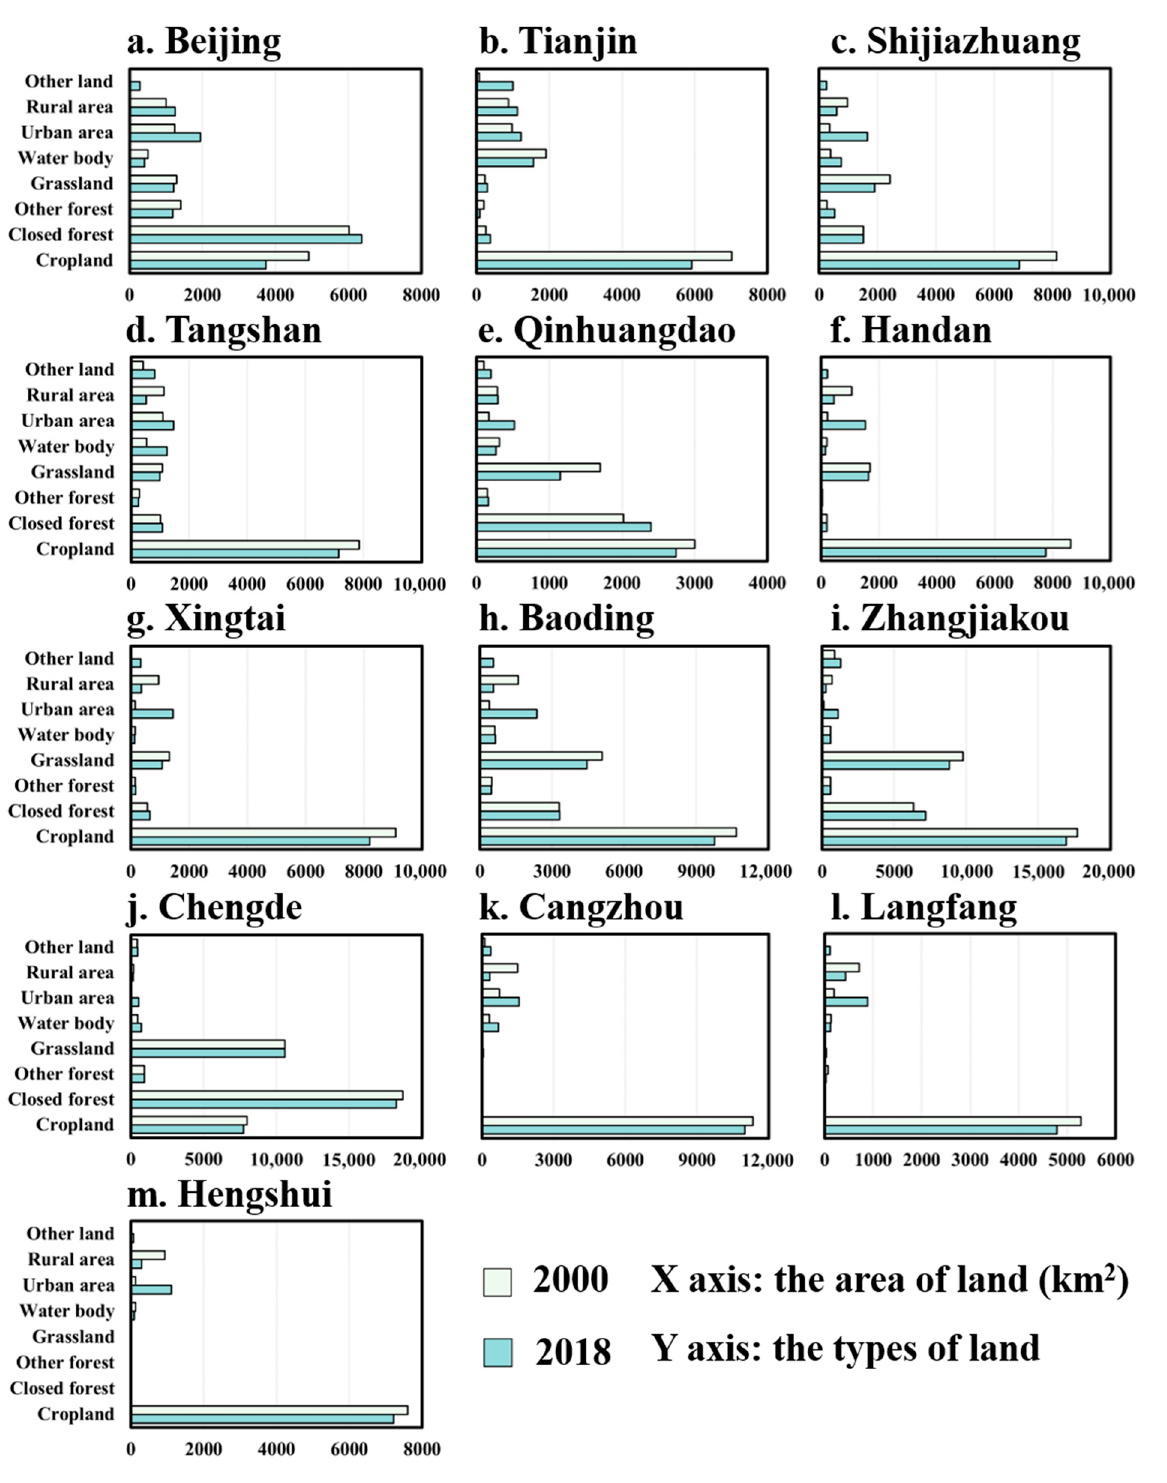
Figure 3. LUCC of 13 cities located in Beijing–Tianjin–Hebei from 2000 to 2018.